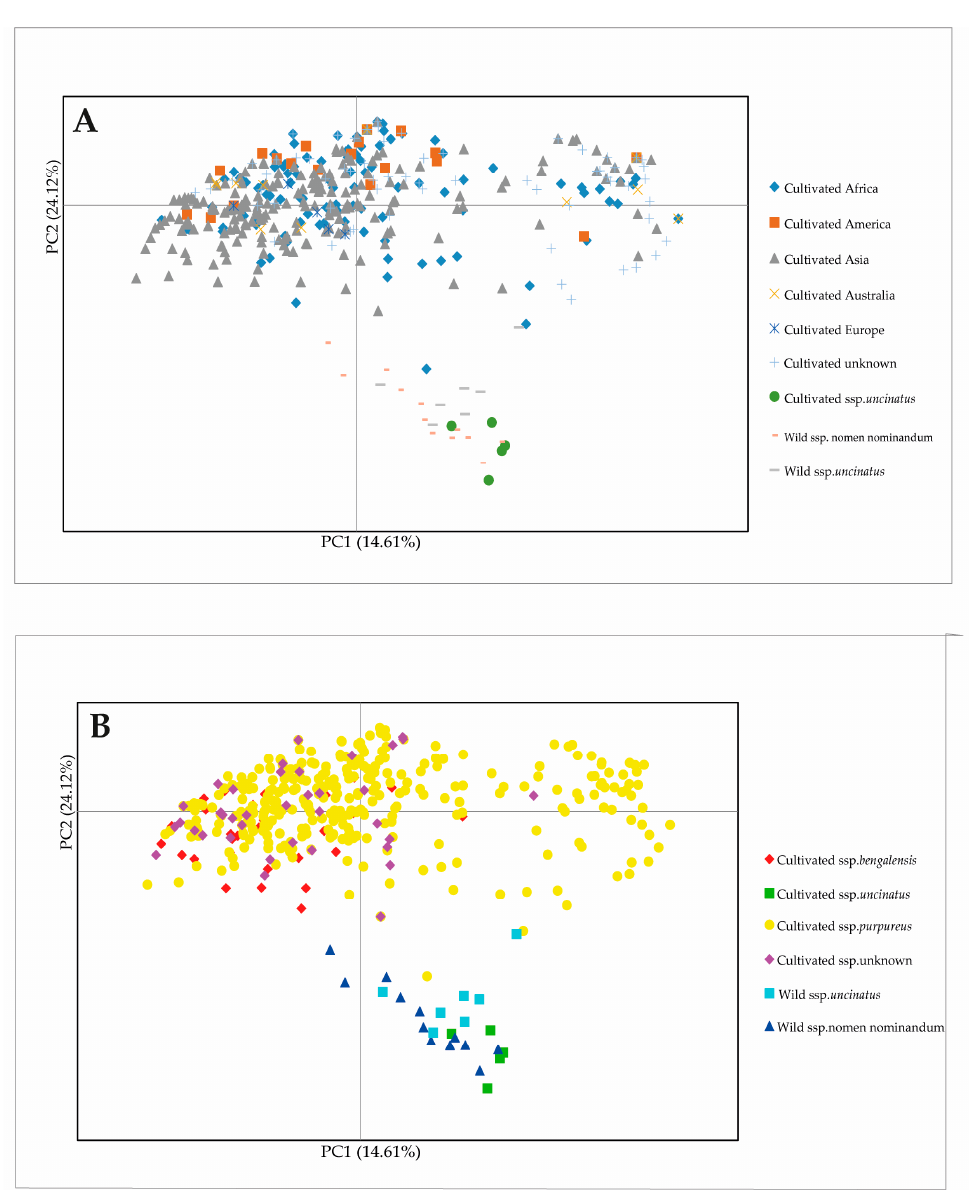
Figure 4. Scatter diagrams of 493 lablab accessions based on the first and second axes of principal coordinate analysis (PC1 and PC2). (A) The accessions are presented based on cultivation status and geographical origins. (B) The accessions are presented based on taxonomical classification.